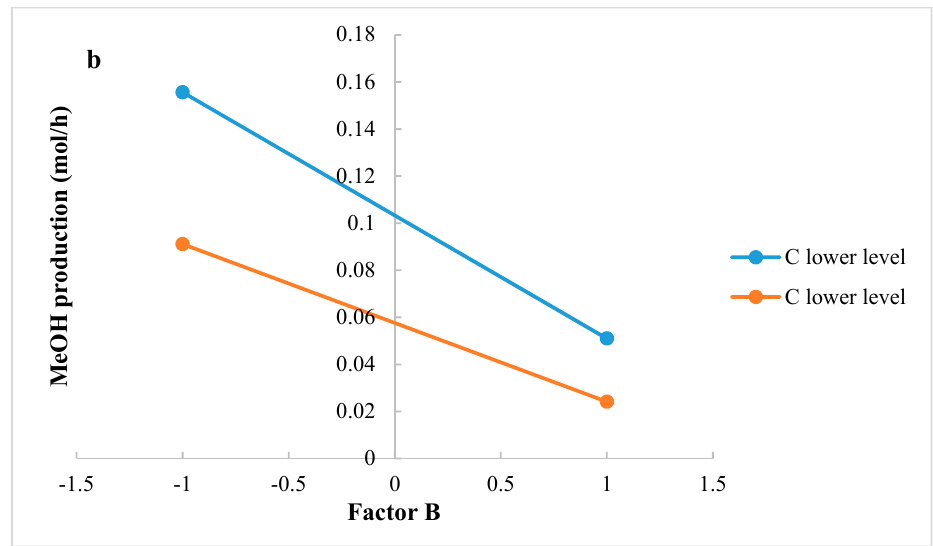
Figure 6. ( a ) Test of two levels for the analysis of interaction AC in methanol production; ( b ) Test of two levels for the analysis of interaction BC in methanol production (A = CO composition in mol%, B = temperature in °C, C = recycle in %, D = water removal in %).